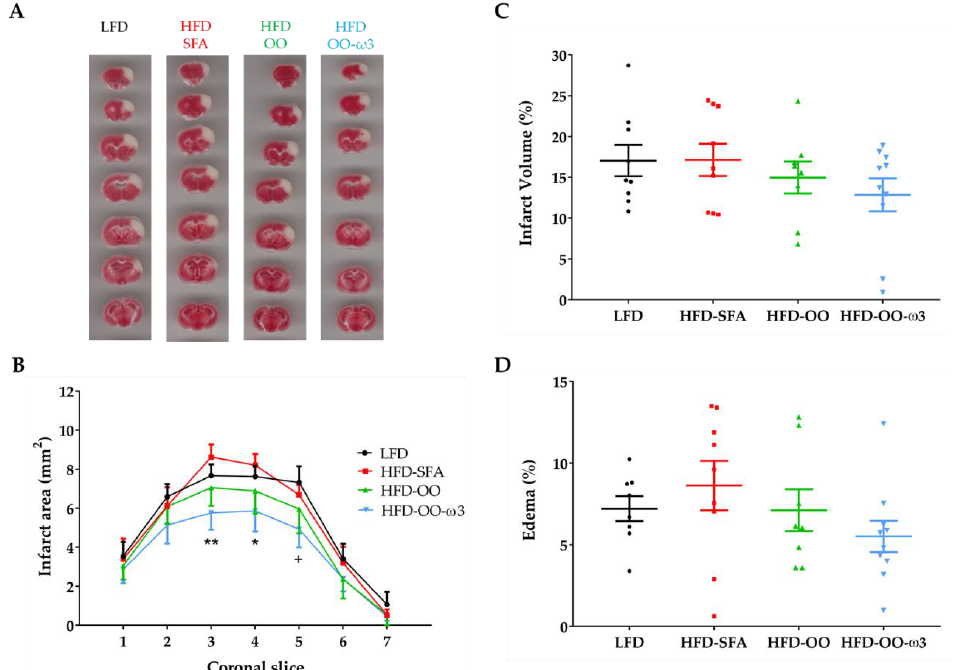
Figure 4. HFD-OO- ω 3 diet reduces the infarct area in an experimental model of focal cerebral ischemia. Groups: LFD (Black), HFD-SFA (Red), HFD-OO (Green), and HFD-OO- ω 3 (Blue). ( A ) Representative images of TTC staining. Seven coronal slices along the rostro-caudal axis are shown, from coordinates bregma AP: + 2.80 to bregma AP: − 2.46 (Franklin and Paxinos atlas [41]). ( B ) The HFD-OO- ω 3 diet reduced the infarct area compared to HFD-SFA and LFD. ( C , D ) show the Infarct volume and